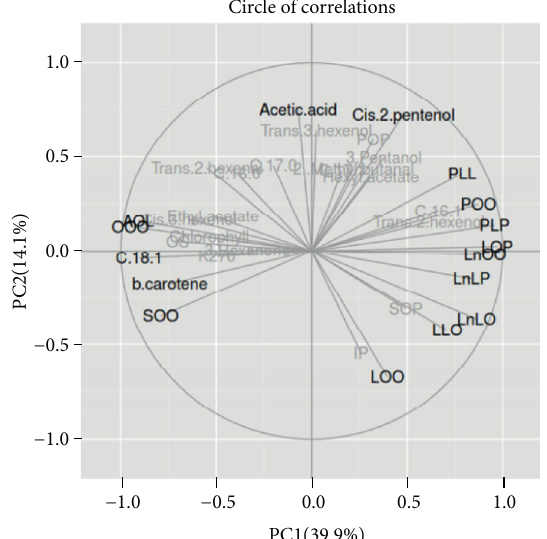
Figure 2: Projection of the variables in the space defined by the first two principal